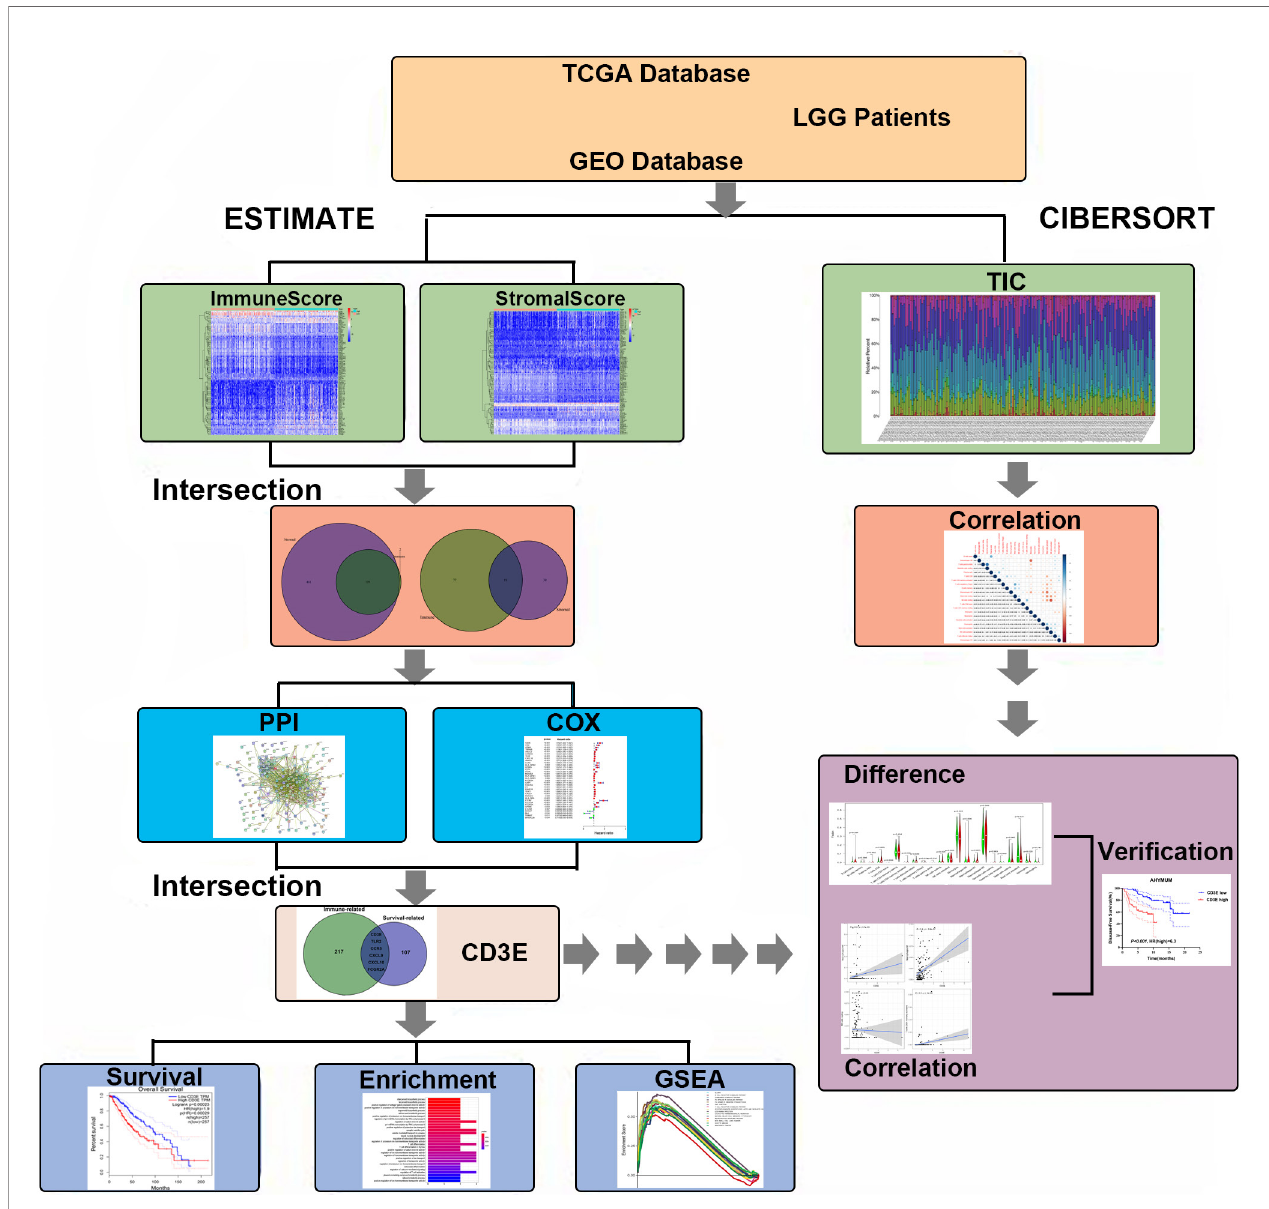
FIGURE 1 | Flowchart of this study. TCGA, the Cancer Genome Atlas; GEO, Gene Expression Omnibus; LGG, low-grade